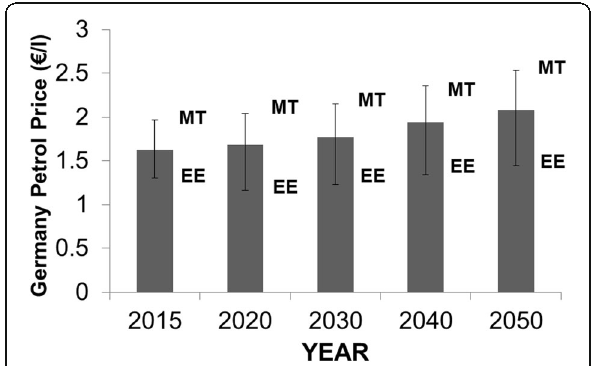
Fig. 2 German petrol price under base conditions ( € /l), showing maximum (Malta - MT) and minimum (Estonia - EE)